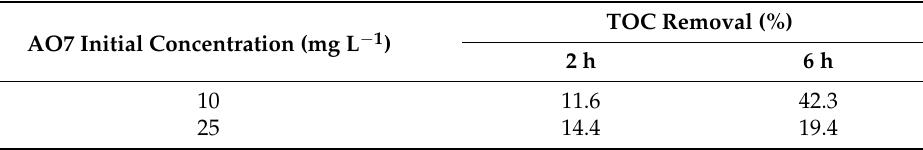
Figure 6. Proposed AO7 degradation pathway. Table 2. TOC removals (%) for the photocatalytic degradation of AO7 with Sr 0.95 Bi 0.05 TiO 3 perovskite (0.2 g L − 1 ) under visible